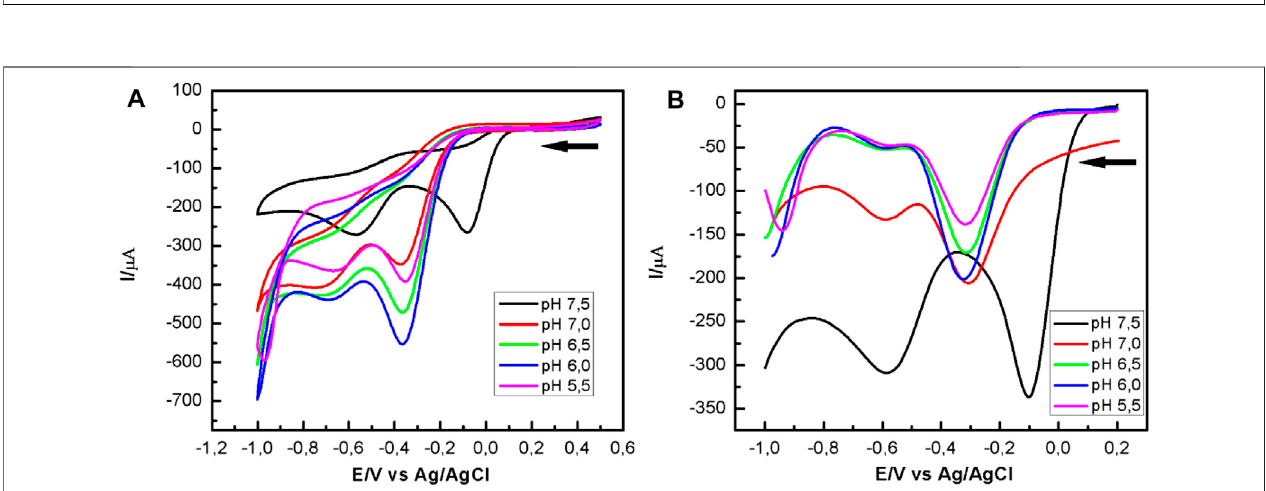
FIGURE 3 | Potentiodynamic response of OPG bare (black line) and CoPc modi fi ed OPG electrode in Mueller Hinton in the absence (red line) and presence (blue line) of P. aeruginosa a pH 7.0: (A) Cyclic voltammograms recorded at 100 mV/s; (B) Square waves voltammograms. Experimental SWV parameters: initial potential